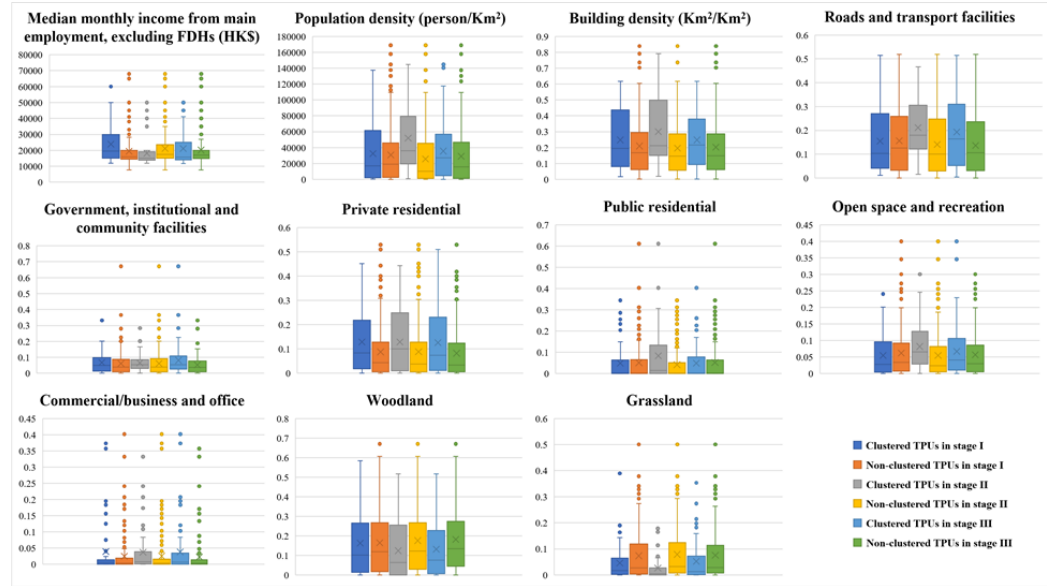
Figure 12. Features ’ distribution of clustered TPUs and non- clustered TPUs of COVID-19 transmis- Figure 12. Features’ distribution of clustered TPUs and non-clustered TPUs of COVID-19 transmission sion in residential locations at different stages of the pandemic in Hong Kong. in residential locations at different stages of the pandemic in Hong Kong. Table 9. Features ’ distribution at different stages of residential location (“ p - value” is performed as asymptotic two-tailed significance of the Mann – Whitney test) .